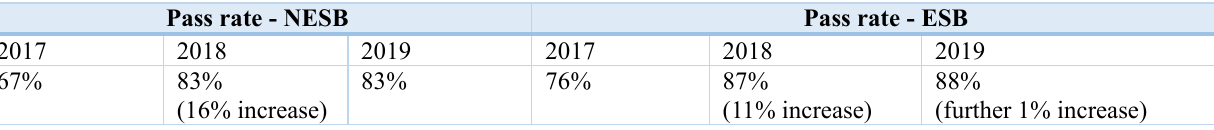
Comparison Between Pass Rate of Non-English-Speaking Background Students and English-Speaking Background Students Pass rate - NESB Pass rate -